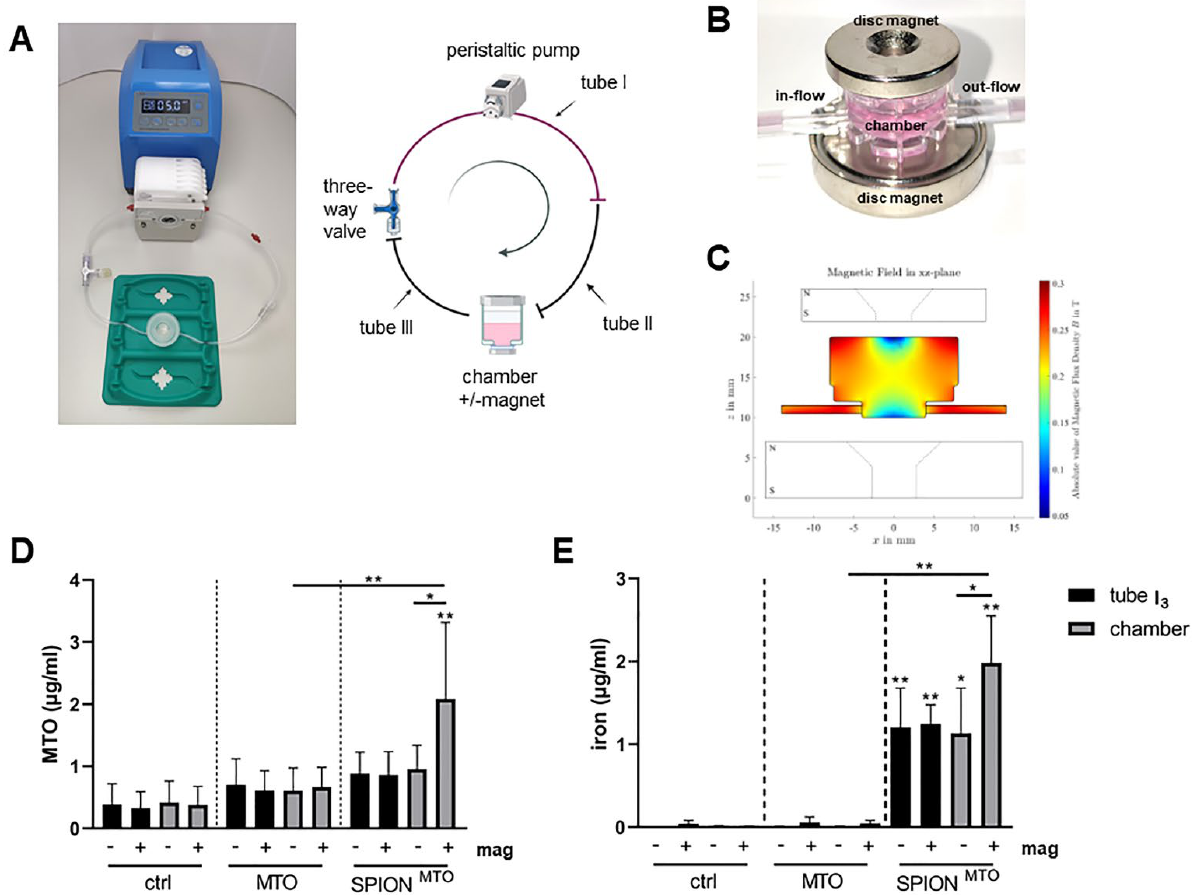
Figure 3. Magnetic accumulation of SPION MTO in a dynamic flow system. Spheroids were incubated in a chamber connected to a peristaltic pump with two tubes. MTO or SPION MTO (MTO amount 2.25 µg) were applied in a bolus. Tube I was exchanged three times with the containing fluid, to mimic distribution of MTO out of the blood circulation into tissues. Samples were analyzed from tube I 3 and the chamber containing the spheroid, after 2.5 h of running. ( A – C ) Experimental setup with overview ( A ), magnetic setup ( B ) and simulation of the magnetic field ( C ). The amount of MTO was determined by HPLC ( D ). 225 µg of SPIONs were applied in bolus, and accumulation in the chamber in the presence or absence of a magnetic field was analyzed using atomic emission spectroscopy ( E ). The experiment was performed three times. The mean values with standard deviations are shown. Significances were calculated within the groups (tubes and channels), using two-way ANOVA: * p ≤ 0.05, ** p ≤ 0.01. To analyze the nanoparticle-mediated accumulation in the presence and absence of a magnetic field, the amount of MTO as well as the amount of iron in the chamber was determined, using HPLC. We also analyzed the MTO content in the system after each change of the tube: as expected, the amount of MTO in the system decreased with every change of the tube (data not shown). Figure 3D depicts the amount of remaining MTO in the chamber and the tube after the third change. As expected, MTO measurements of the controls only showed background levels. With free MTO applied, more MTO was detected in the tube and the chamber. The application of a magnet did not increase the MTO amount in the chamber. In contrast, with SPION MTO , similar levels of MTO were detected in the tube and in the chamber (without magnet), which were also comparable to those measured for free MTO. In the presence of a magnet, however, SPION MTO were accumulated in the chamber (Figure 3D).